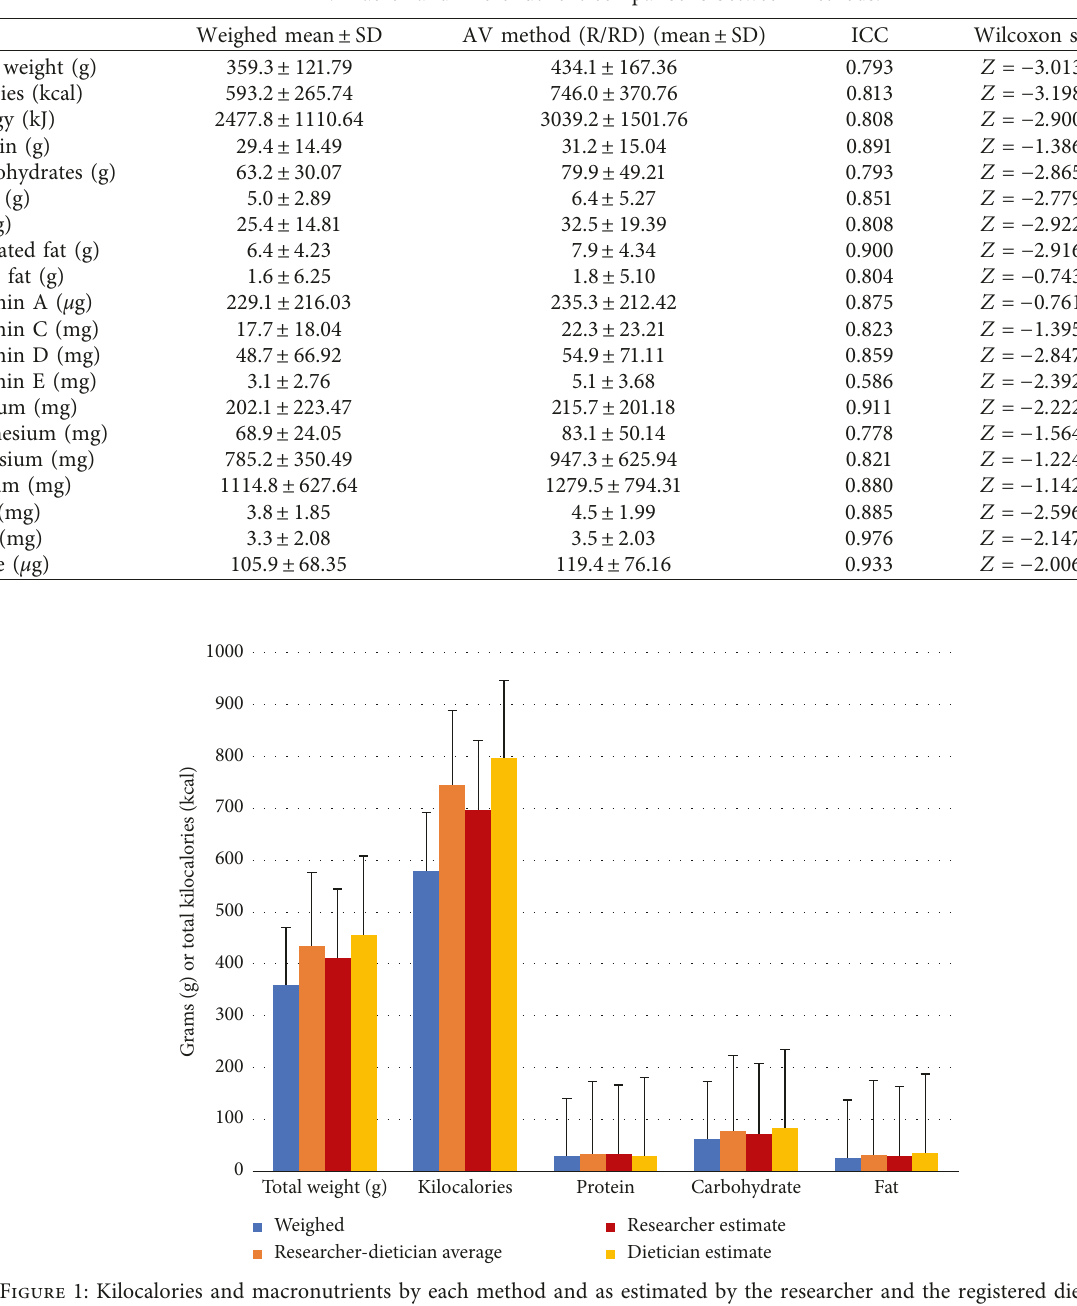
Table 2: Macro- and micronutrient comparisons between methods.